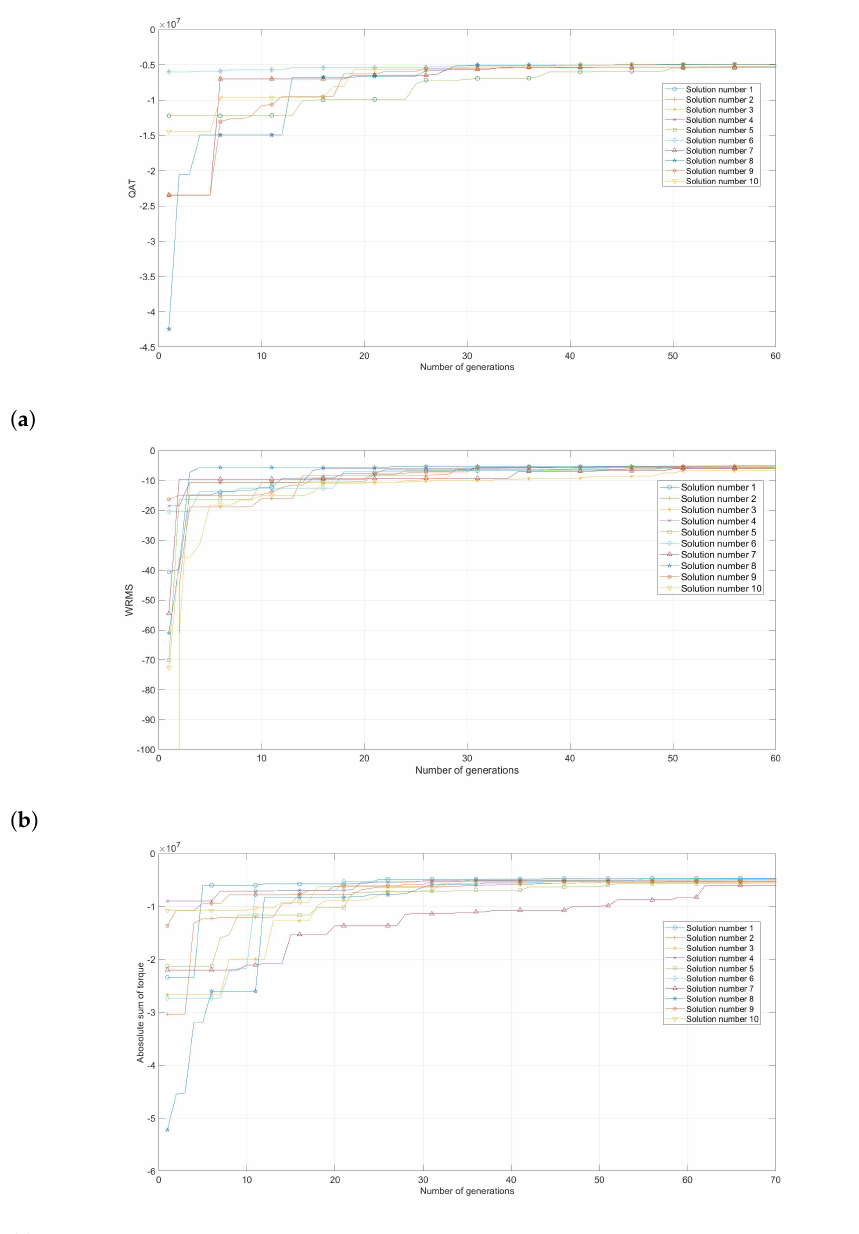
Figure 7. Evolution of the each index from 10 random initial generations. ( a ) QAT, ( b ) WMRS, ( c )